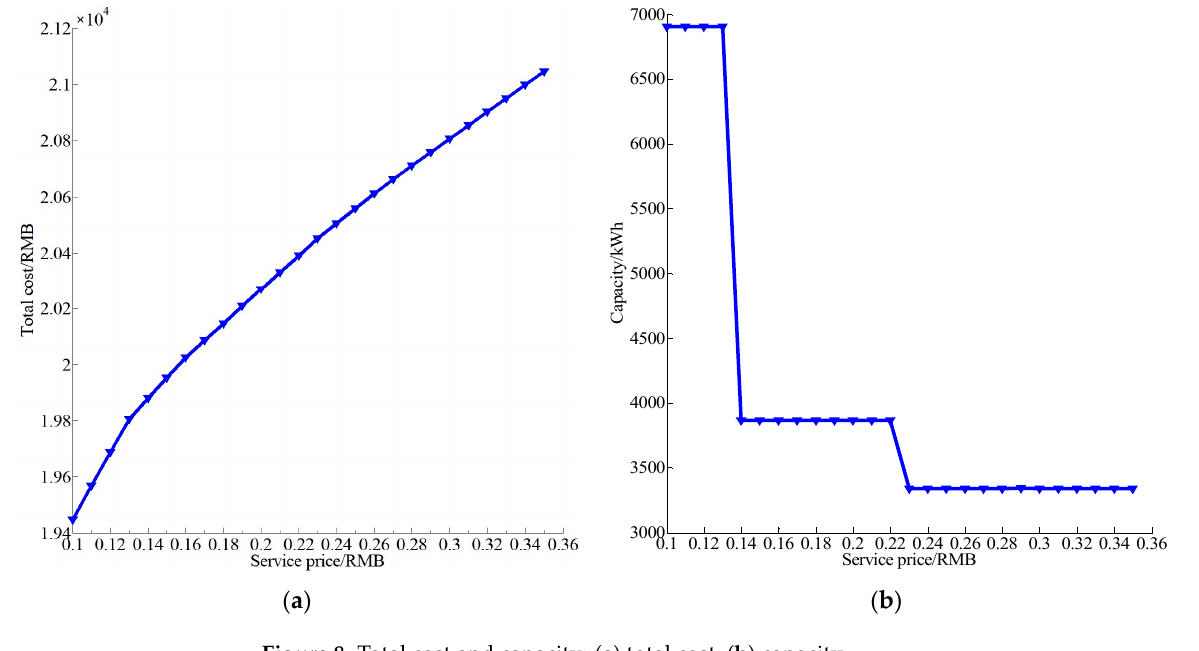
Figure 8. Total cost and capacity: ( a ) total cost; ( b ) capacity.